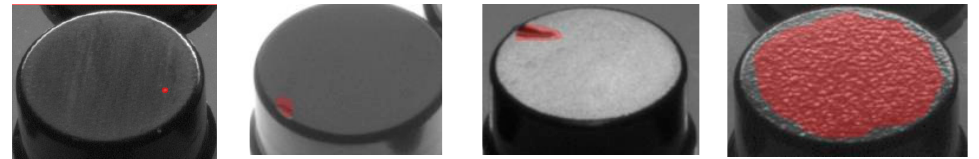
Figure 3. Examples for detected failures based on filter-based image processing (form left to right: inclusion, notch, notch, orange skin—all on front surface).